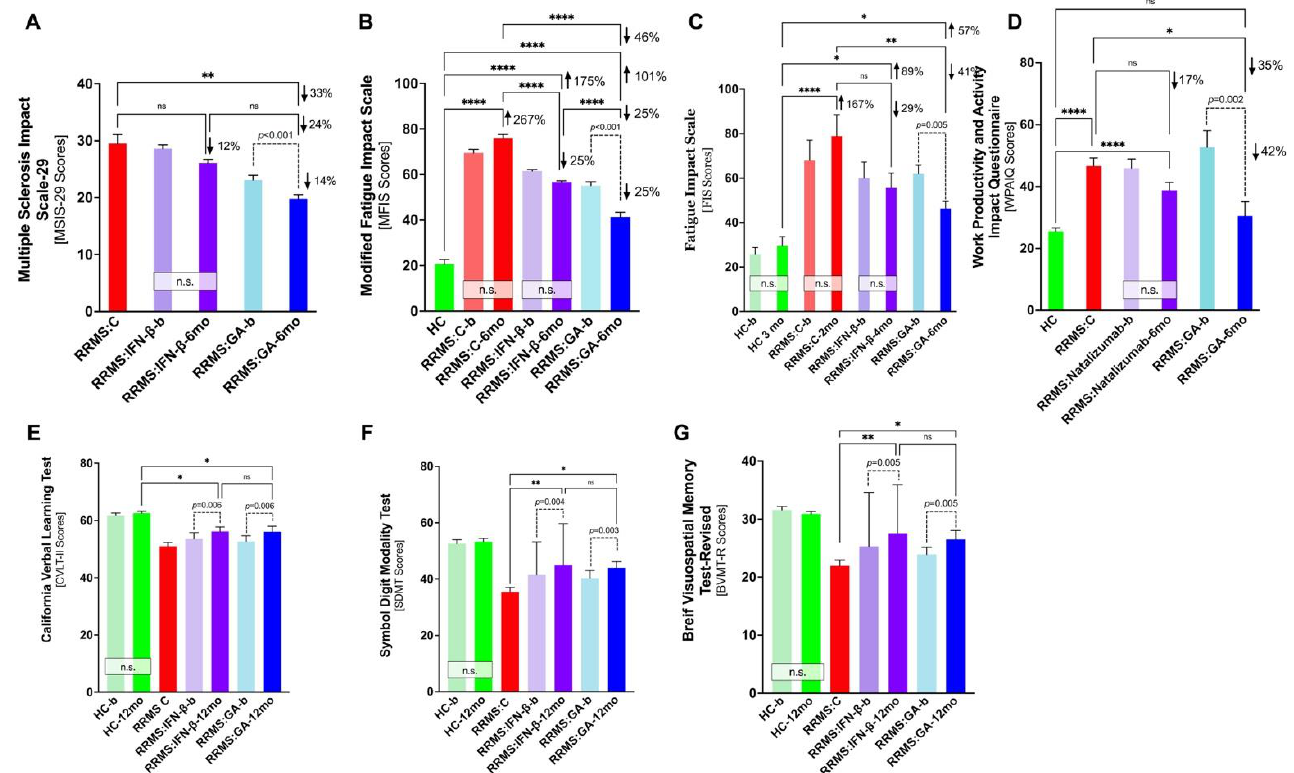
Figure 1. Cognitive and Behavioral studies involving RRMS patients following GA immunization treatment. ( A ) MSIS-29 examines the physical, cognitive, and psychological impacts of multiple scle- rosis on participants’ lives. Statistically significant improvement between RRMS controls and GA after 12 months group with a 33% decrease. A statistically significant improvement between GA baseline and 12 months of GA treatment, with a 14% decrease ( p < 0.001). No significant change in INF- β -treated RRMS cohort. There was a 12% decrease in scores between RRMS controls and INF- b treated as compared to 33% decrease between RRMS controls and RRMS GA-treated cohort. ( B ) MFIS examines fatigue. Statistically significant improvement between RRMS controls and GA after 12 months group with a 46% decrease. A notable improvement between GA baseline and 12 months of GA treatment, with a 25% improvement ( p < 0.001). No significant change in RRMS controls and INF- β -treated cohorts. ( C ) FIS examines fatigue. Statistically significant improvement between RRMS controls and GA after 12 months group with a 35% decrease. An even more notable statisti- cally improvement between GA baseline and 12 months of GA treatment, with a 45% increase ( p = 0.002). No significant change in natalizumab treated RRMS cohort. Additionally, no significant dif- ference between healthy controls 6 months of natalizumab treatment. ( D ) WPAIQ examines produc- tivity and disease impact on activity/productivity. Important to note, no significant difference be- tween healthy controls and GA-treated RRMS patients. Statistically significant improvement be- tween RRMS controls and GA after 12 months group with a 35% decrease. An even more notable statistically improvement between GA baseline and 12 months of GA treatment, with a 45% increase ( p = 0.002). No significant change in IFN- β treated RRMS cohort. Additionally, no significant differ- ence between RRMS controls and 6 months of IFN- β treatment. Graphs ( E – G ) represent the 3 tests that make up the BICAMS. ( E ) CVLT-II examines verbal learning and memory. No significant change in healthy controls. A 19% decrease in scores between healthy controls at 12 months and RRMS controls as compared to 10% decrease between healthy controls and RRMS GA-treated co- hort. Statistically significant improvement between RRMS controls and GA after 12 months group with a 25% increase. No statistical difference between INF- β -treated cohorts at 12 months and GA- treated cohorts at 12 months. Statistically significant increase/improvement/change between GA baseline and 12 months of GA treatment ( p = 0.006). ( F ) SDMT, a test of short-term, visual, and working memory. No significant change in healthy controls. A 34% decrease in scores between healthy controls at 12 months and RRMS controls as compared to 18% decrease between healthy controls and GA-treated RRMS cohort. Statistically significant improvement between RRMS